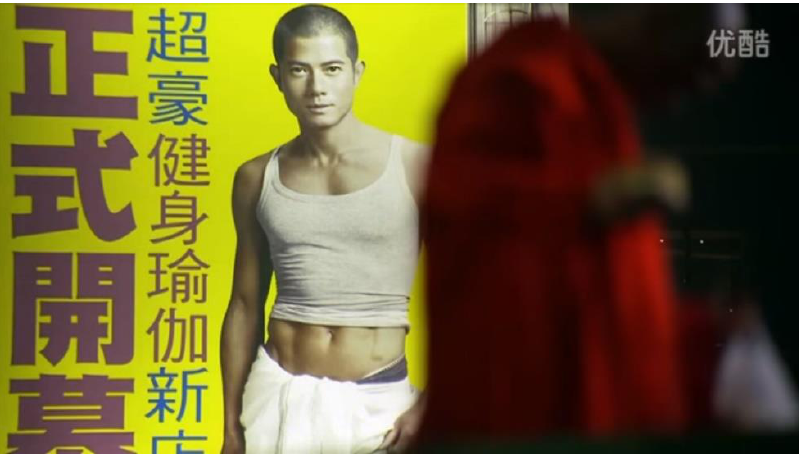
Figure 7. Perspectivist camera trick rendering (the images of) two performers the same size.